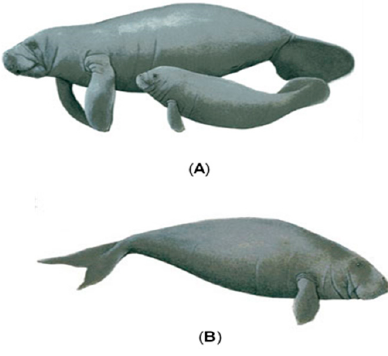
Figure 1. Representation of: ( A ) Trichechus manatus (manatee) and ( B ) Dugong dugon (dugong), taken from Save the Manatee Club [48].